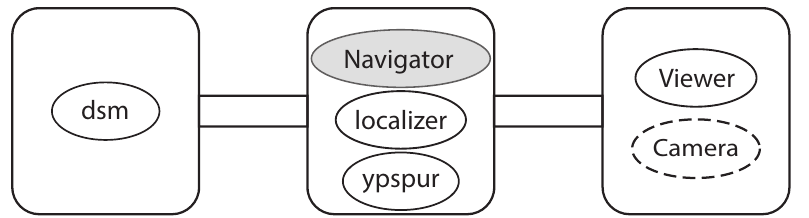
Figure 9. Locations of each process. Table 6. Specifications of Raspberry Pi 4 model